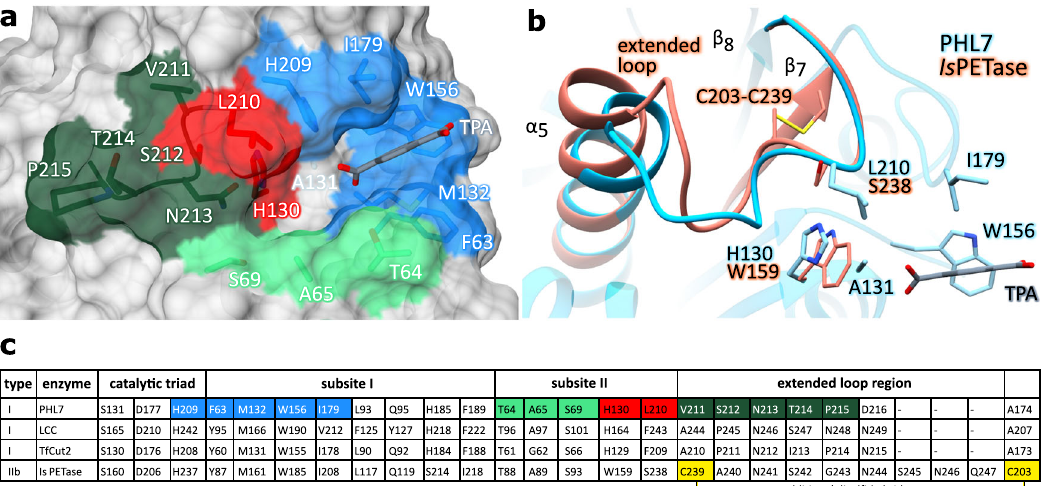
Fig. 1 | Subsites I and II of polyester hydrolases. a Surface representation of PHL7×TPA. TPA (gray) binds to subsite I (blue). Residues comprising the putative subsite II are conserved or semi-conserved (light green), cover a loop that is elongated in mesophilic homologs (dark green) or differ signi fi cantly between polyester hydrolases (red). b Superimposition of PHL7×TPA (light blue) with Is PETase (salmon, PDB ID: 5XJH). An extended loop covering residues C239-Q247 of Is PETase deviates from its equivalent region (V211-D216) of PHL7 and is stabi- lized by a non-conserved disul fi de bridge (C203-C239). Activity-regulating L210 liesupstreamofthatloopandspatiallyclosetoH130. c Comparisonofstructurally